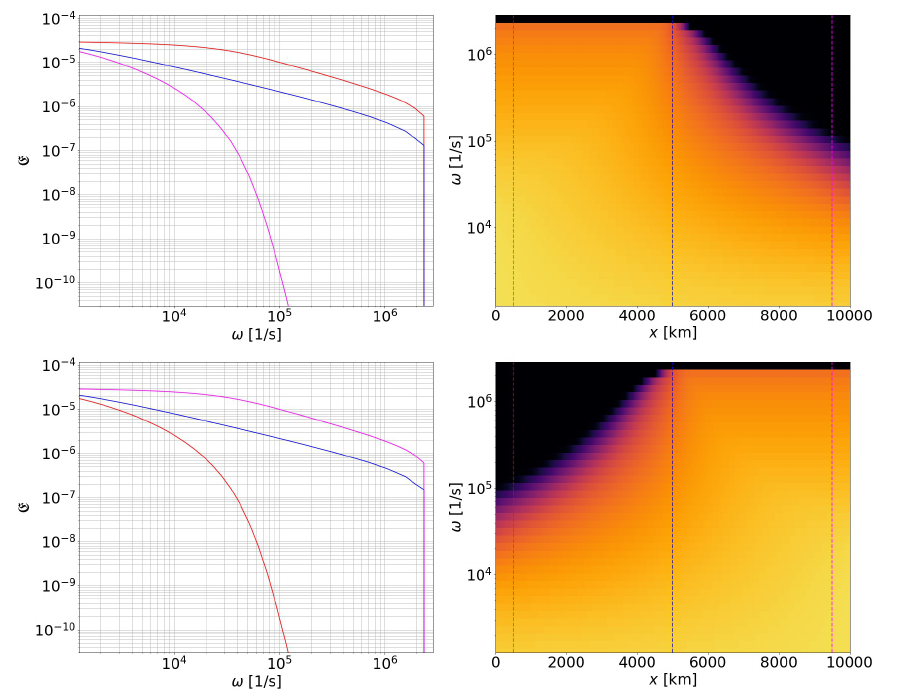
Figure 2. Steady state of the simulation of a coronal loop with equal wave spectral energy density injections at both footpoints. Upper plots contain the parallel-propagating wave spectrum and bottom plots contain the anti-parallel-propagating wave spectrum. The plots on the left contain slices of the wave spectral energy density data at three locations, which are color coded to match the dashed lines on the contour plots. The normalization value for this simulation is α = 3 × 10 − 5 , the loop size L = 10,000 km, and the spatial cell size ∆ x = 20